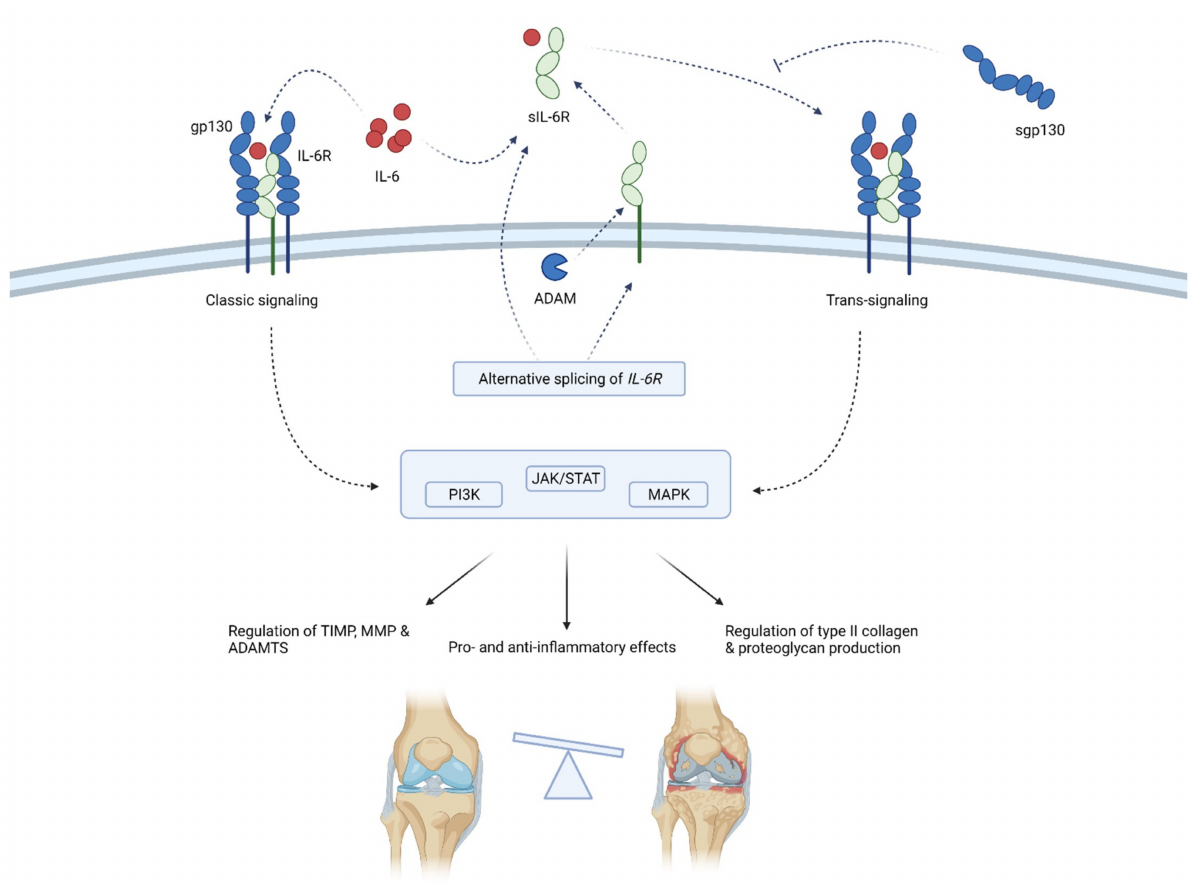
Figure 4. Schematic representation of IL-6 function in osteoarthritis pathogenesis. IL-6 acts by binding membrane- bound IL-6R or sIL-6R that associates with gp130. Gp130 initiates intracellular signaling that regulates the inflammation and expression of enzymes, collagen and proteoglycans. sIL-6R is produced by means of alternative splicing or the shedding of membrane-bound IL-6R. sgp130 can inhibit IL-6 signaling. Through classic and trans-signaling, IL-6 activates the PI3K, JAK/STAT and MAPK signaling pathways that regulate enzymes production (TIMP, MMPs and ADAMTS) and type II collagen and proteoglycan synthesis. Thus, IL-6 balances between anti-inflammatory and proinflammatory effects, but the latter predominates, ultimately leading to the progression of osteoarthritis. ADAM—a disintegrin and metalloproteinase; ADAMTS—a disintegrin-like and metalloproteinase with thrombospondin motifs; gp130—glycoprotein 130; IL-6—interleukin-6; MMP—matrix metalloproteinases; sgp130—soluble glycoprotein 130; sIL-6R—soluble IL-6